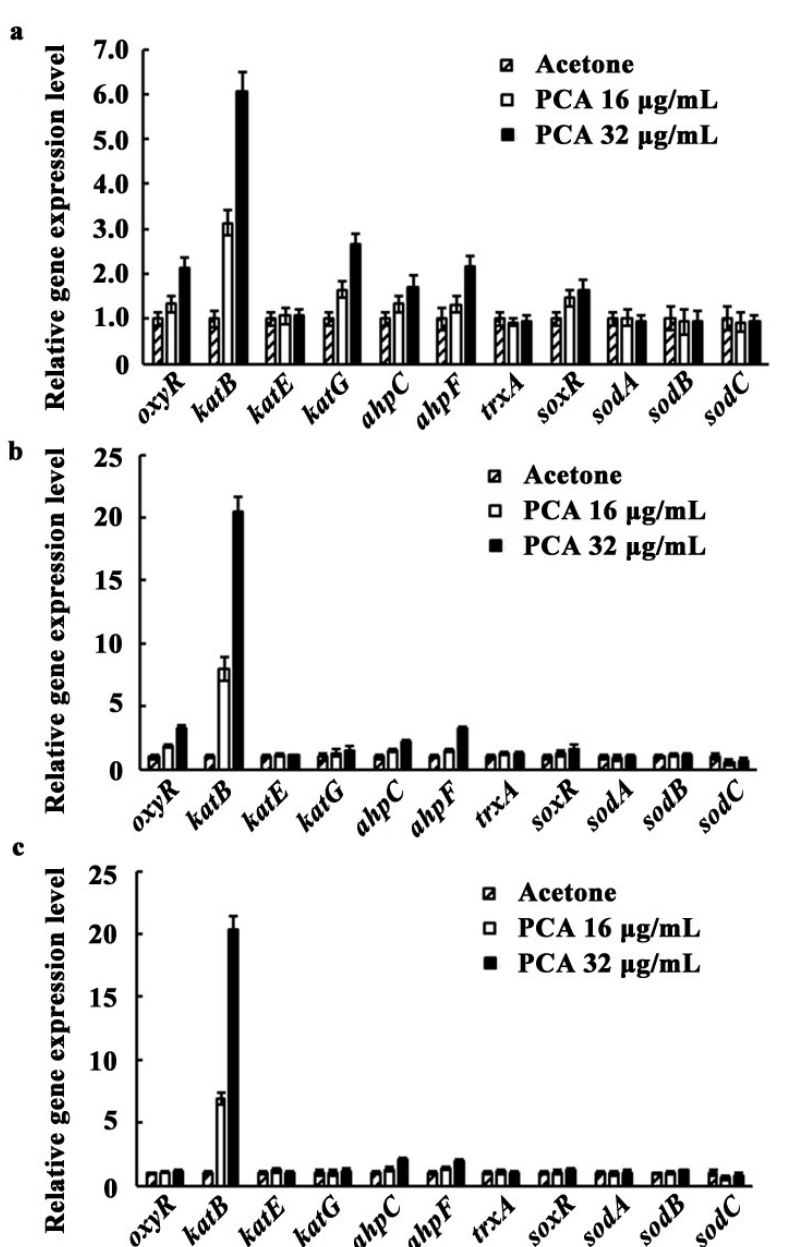
Figure 6. Expression of oxyR , soxR , and the genes involved in antioxidant systems in A. citrulli as affected by PCA. Strain XJX12 was grown in liquid LB medium containing acetone solution without or with PCA to OD 600 values of 0.1 (with culture time 6 h) ( a ), 0.2 (with culture time 8 h) ( b ), and 0.35 (with culture time 10 h) ( c ). The amount of RNA in acetone was used as the control and was set at 1.0. The XJ-RT gene (GenBank number: CP000512.1) was used as an internal control in the qRT-PCR assay. The experiment was repeated three